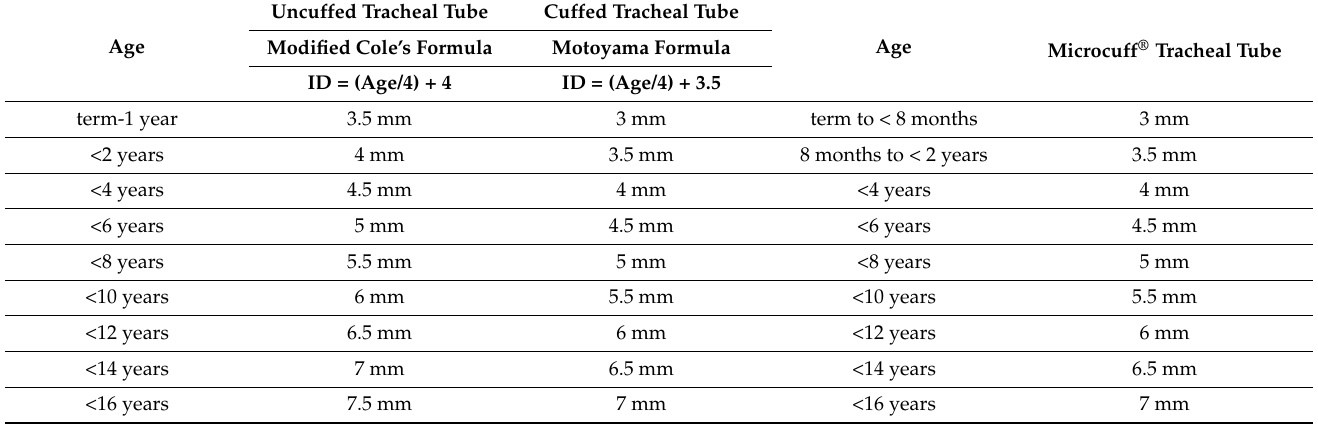
Table 1. Recommended tube sizes for pediatric